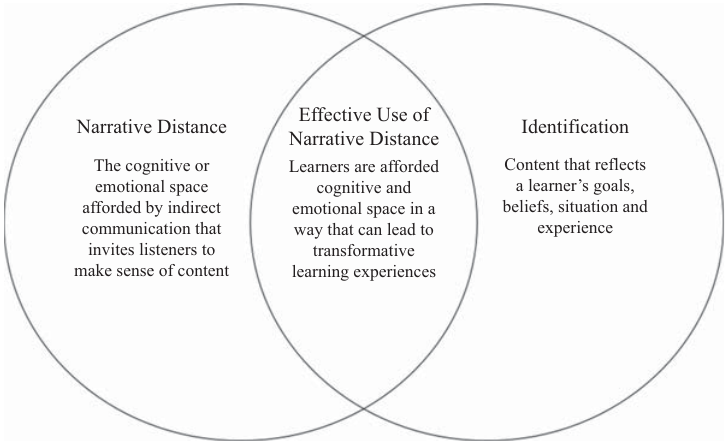
Figure 1. The combination of narrative distance and identification can lead to transformative learning